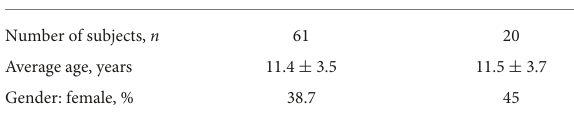
TABLE 1 Characteristics of subjects in the two groups who completed the study.